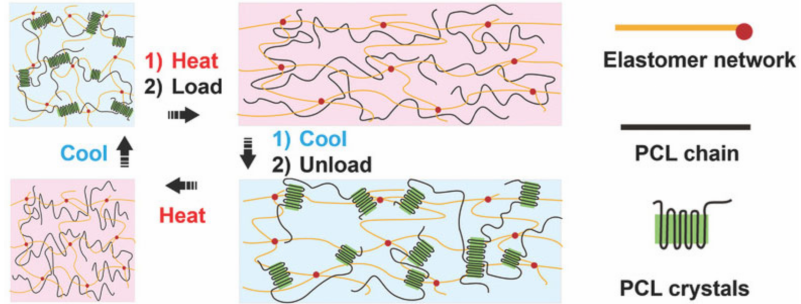
Figure 62. Diagrams showing the mechanism of shape memory behavior. Reproduced from [259] with permission from John Wiley and